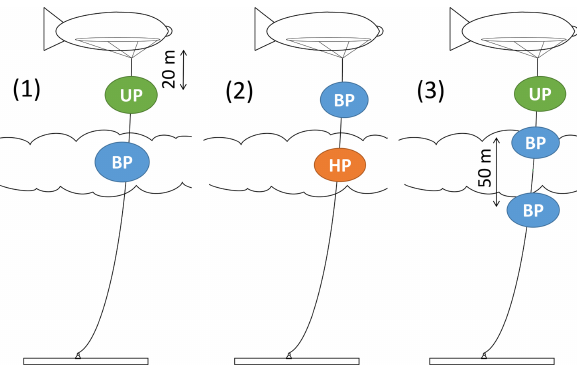
Figure 2. Three main instrument configurations on the tethered bal- loon: (1) configuration 1 with an ultrasonic anemometer package (UP) and a broadband radiation package (BP), (2) configuration 2 with a BP and a hot-wire anemometer package (HP), and (3) con- figuration 3 with an UP and two BPs. Due to the modular approach, further configurations are possible. Distances and dimensions are not to scale.